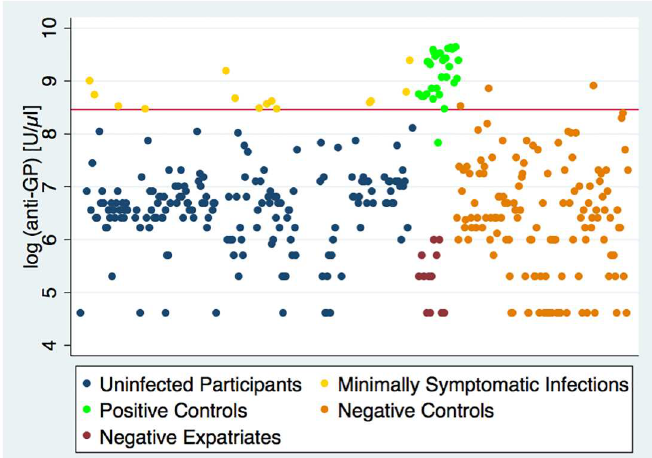
Fig 3. log (anti-GP) for 187 study participants, 132 negative controls, 30 positive controls, and 12 negative expatriates. The red line represents a cutoff of 4.7 U/mL [log (4700 U/ μ l) = 8.46], which yielded 96.7% sensitivity and 97.7% specificity in distinguishing